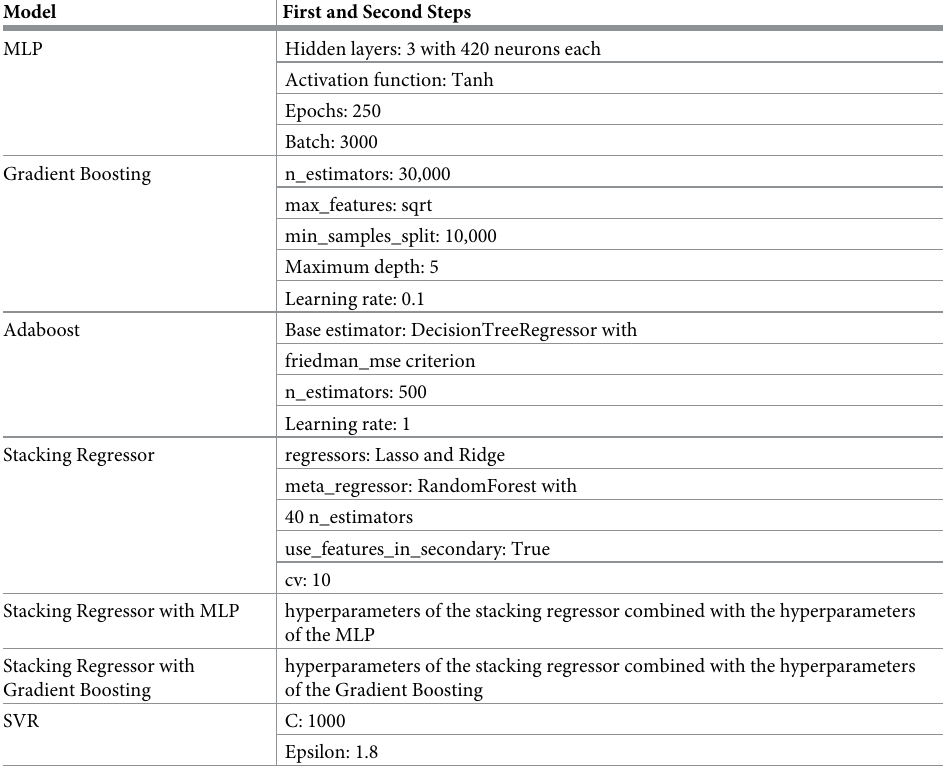
Table 7. Final settings for the